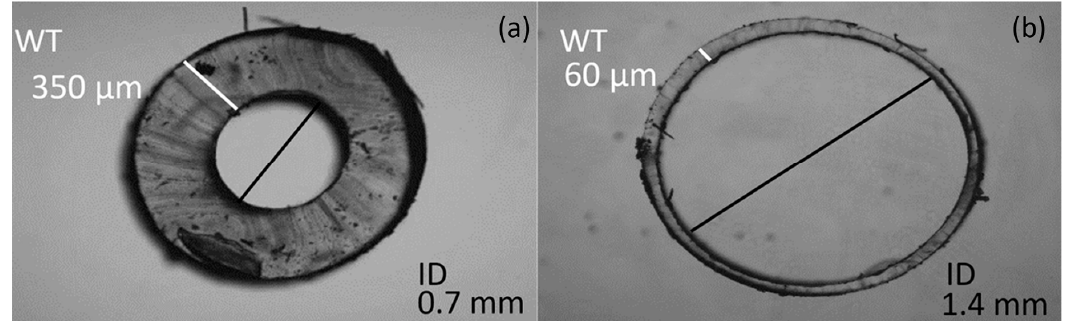
Figure 2. Images of vessel cross sections. Commercial vessel (ID = 0.7 mm) ( a ). Custom Vessel (ID =